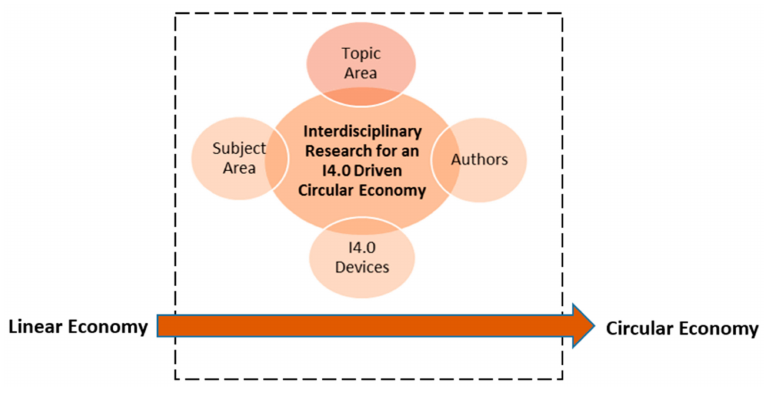
Figure 11. Multidisciplinarity in Industry 4.0 for CE